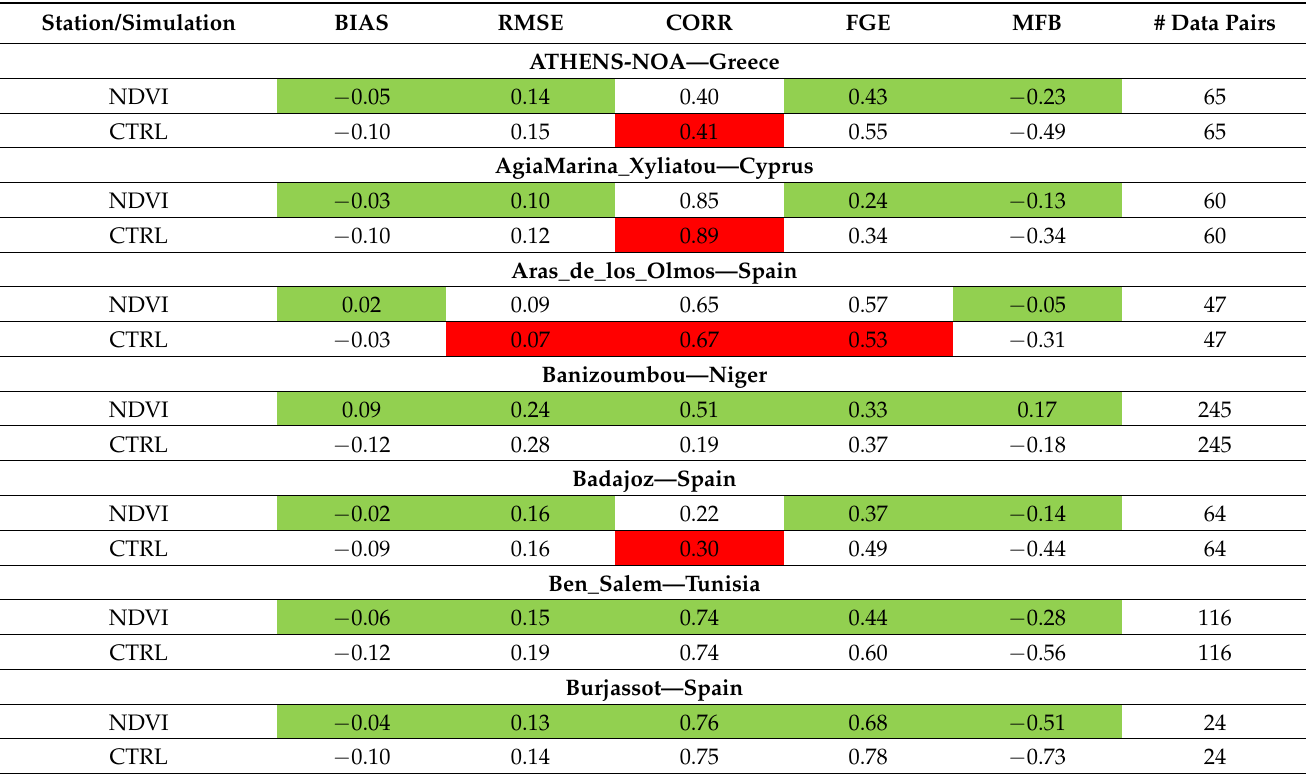
Table 3. Statistical indexes for the 34 AERONET stations used in this study. Green color cells denote model improvement for the NDVI simulations, while red cells denote that the CTRL simulations give better results for each station. For each station, the country is also